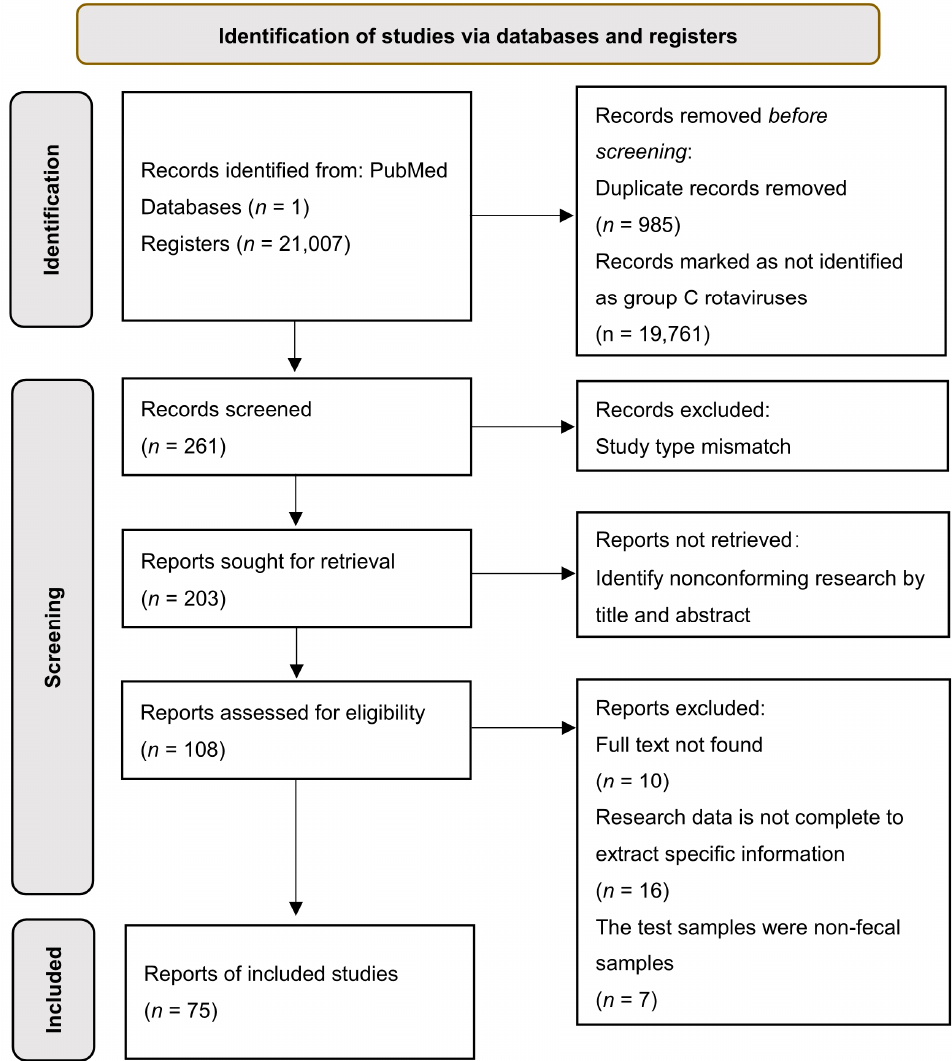
Figure 1. Flow diagram of the literature search and selection process for this study.